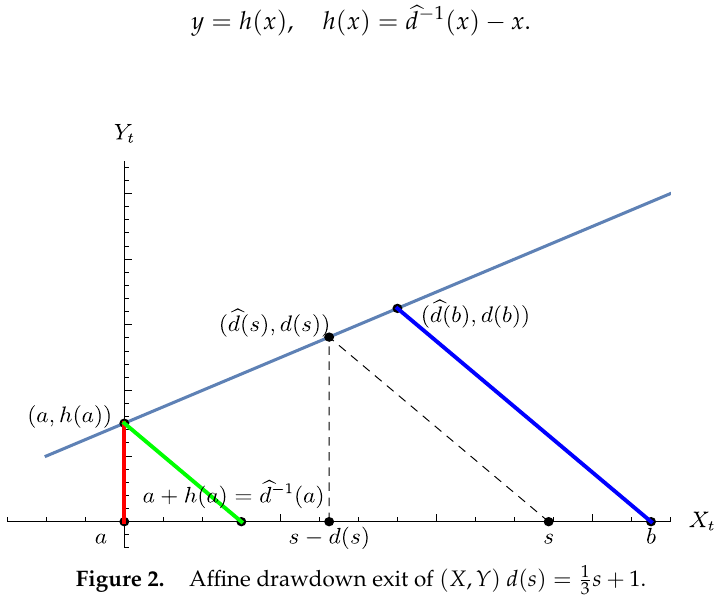
Figure 2. Affine drawdown exit of ( X , Y ) d ( s ) = 1